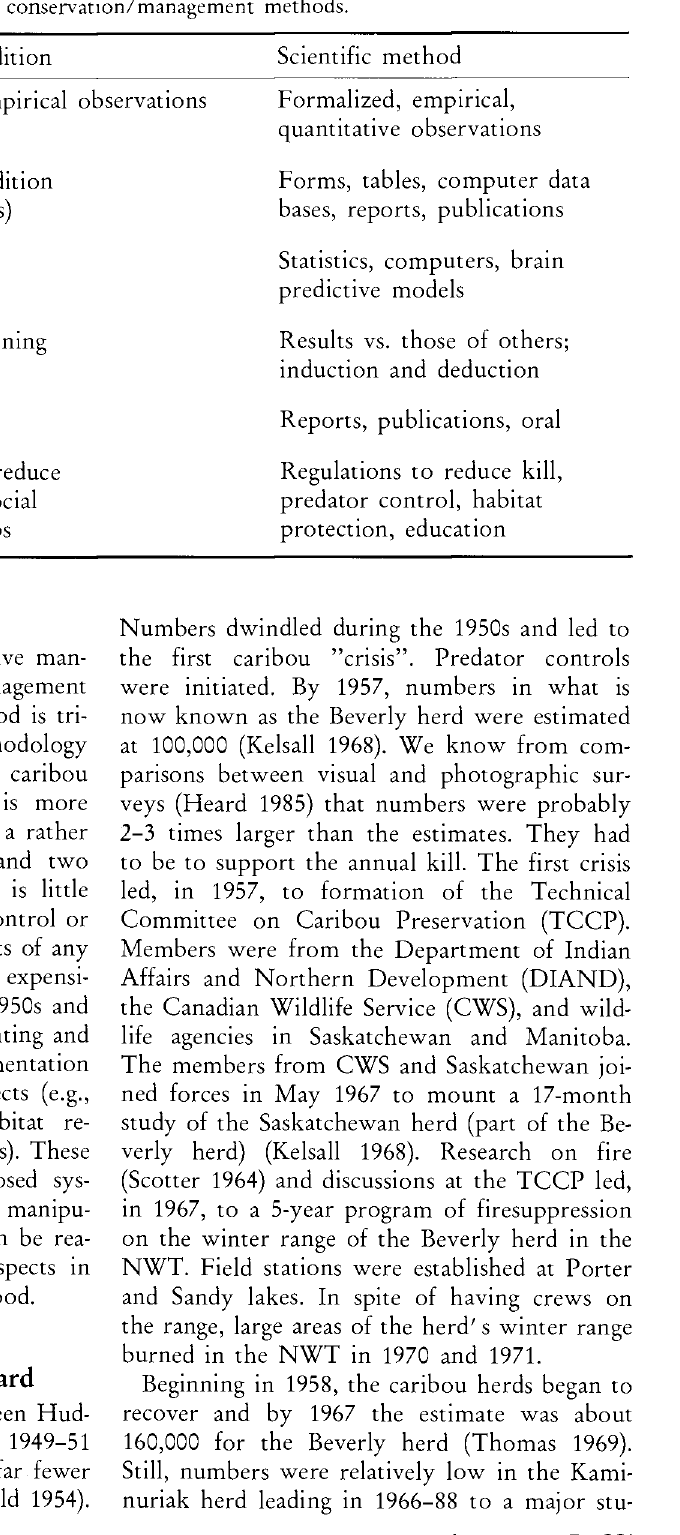
Table 1. Major similarities and differences between the indigenous tradition and the scientific method of data gathering and processing and major conservation/management